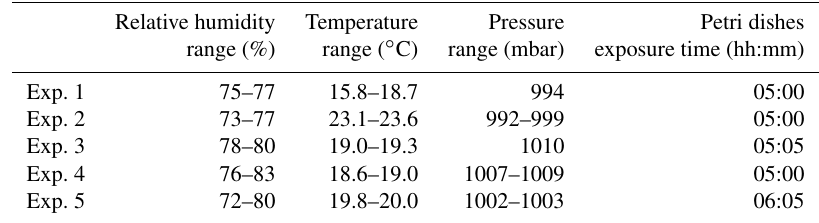
Table 3. Environmental parameters (RH, T , P ) in ChAMBRe during the experiments with E. coli . Relative humidity